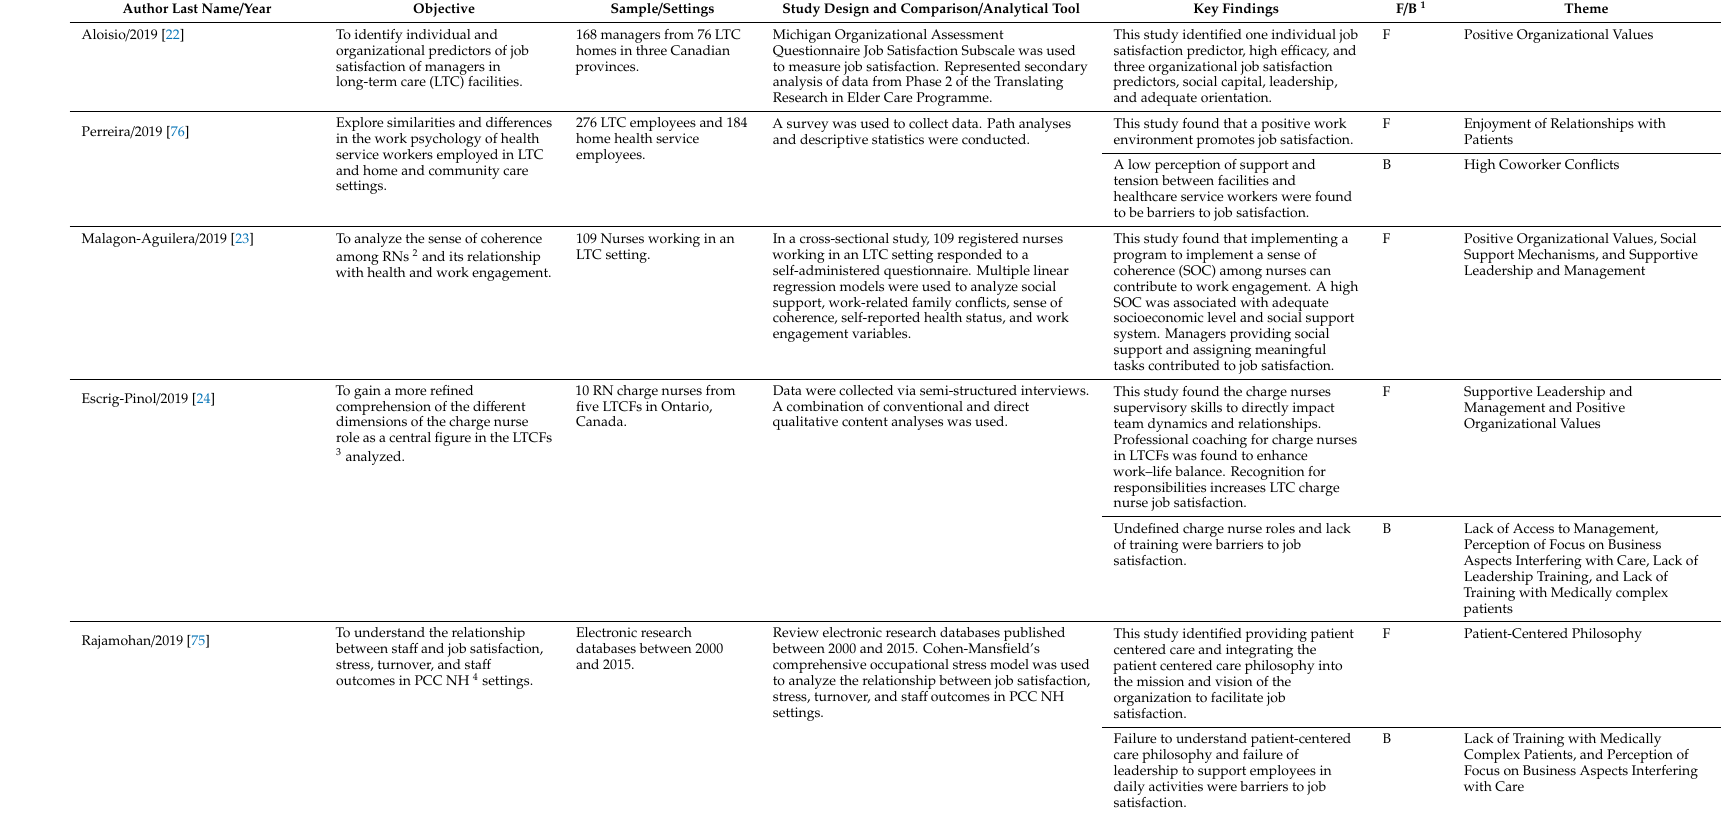
Table A1. Summary of